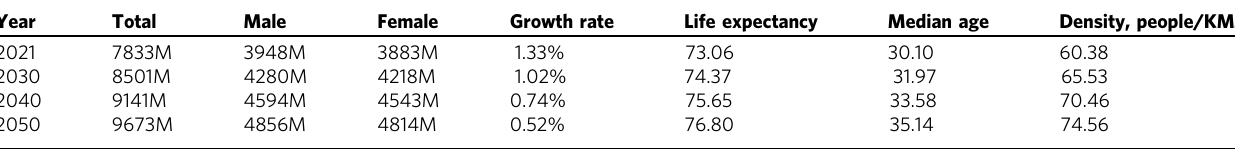
Table 4 World population projection from 2021 –